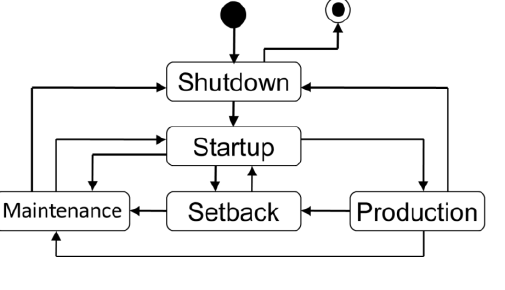
Figure 3. Activity states in a manufacturing